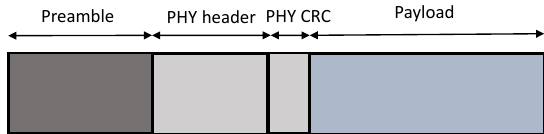
Figure 2. LoRa frame